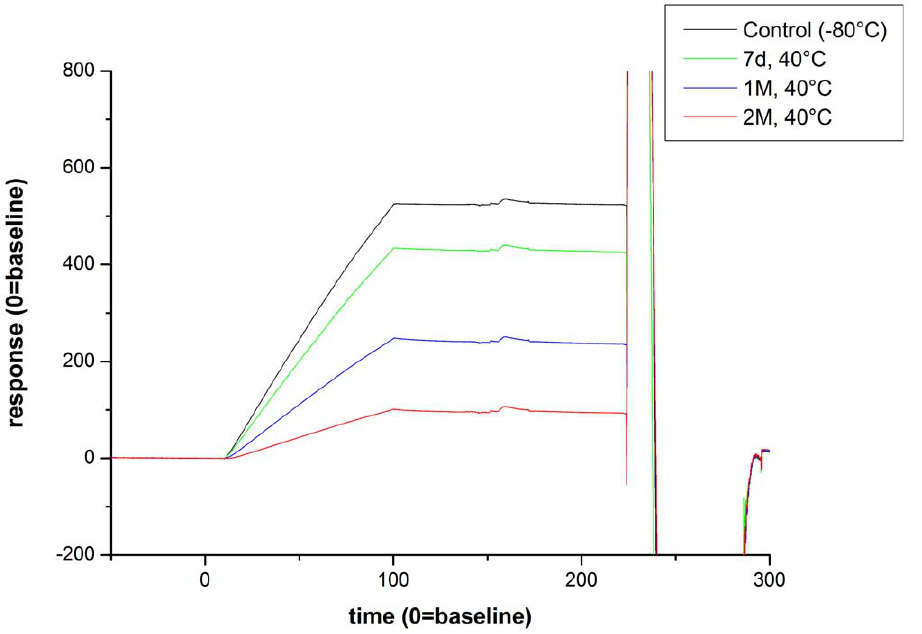
Figure 9. Analysis of Mab1 target binding by surface plasmon resonance. Biacore sensorgrams showing the target binding of non-stressed Mab1 material (stored at 2 80 u C) and following elevated temperatures (storage at 40 u C for 7 days, 1 month, and 2 month) at a flow rate of 100 m l/min.